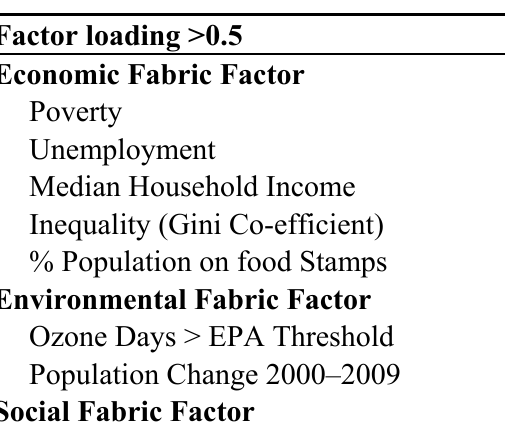
Table 2. Final fabric indicators for the Human Security Index (HSI) for